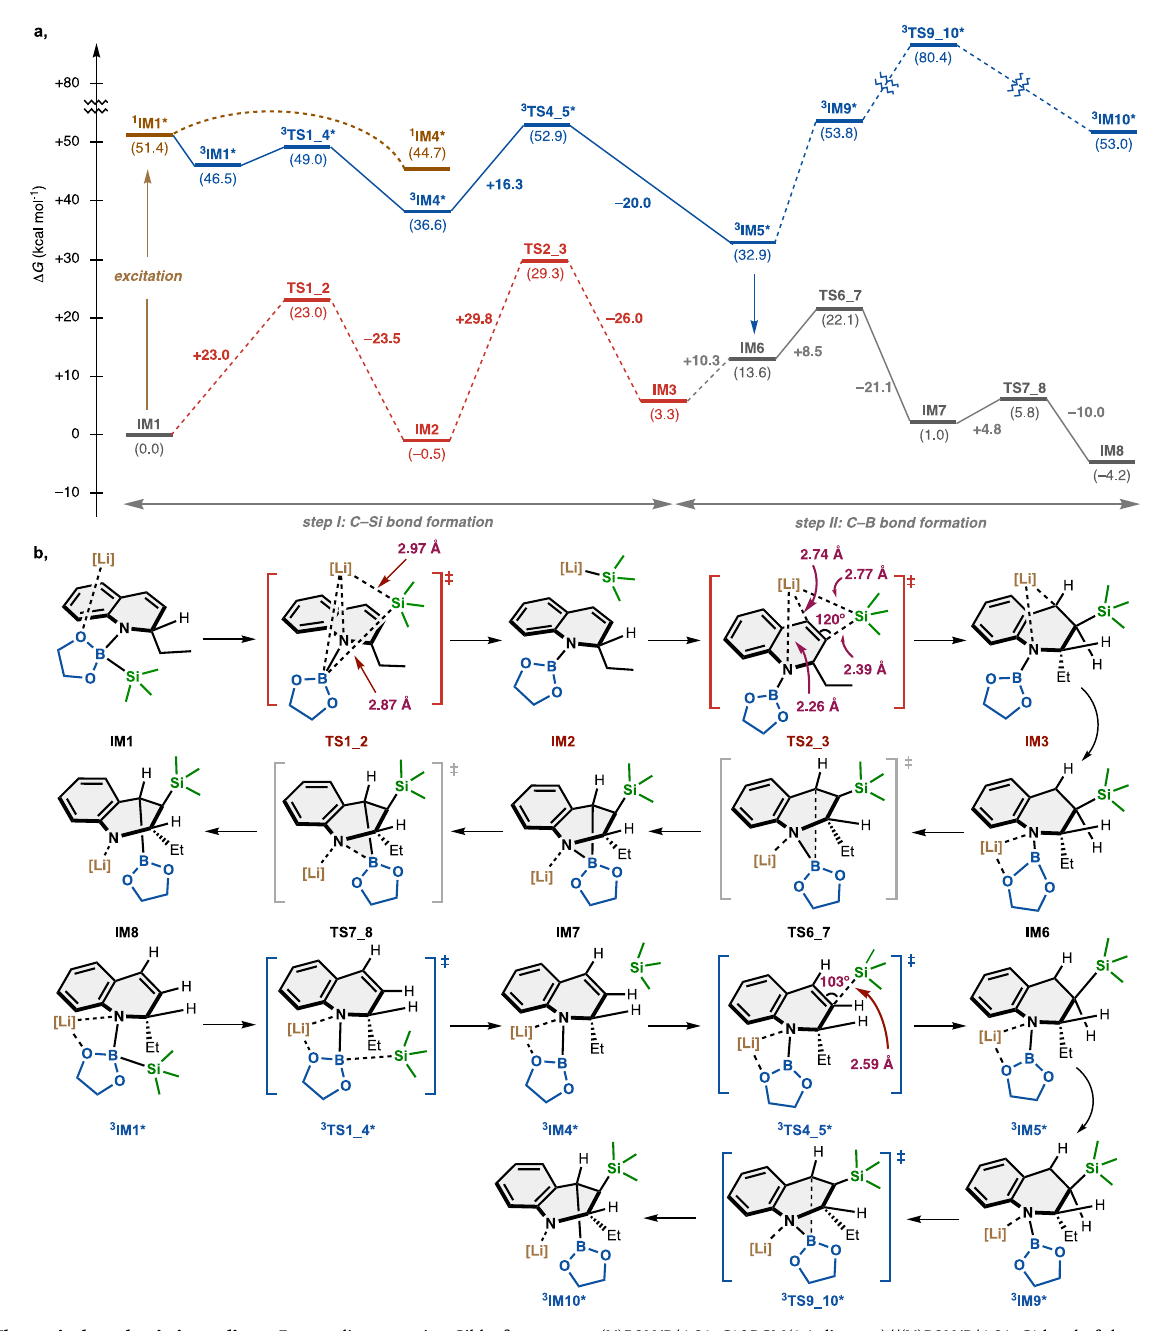
Fig. 6 | Theoretical mechanistic studies. a Energy diagram using Gibbs free energies. b Chemical structures of intermediates and transition states. Gibbs